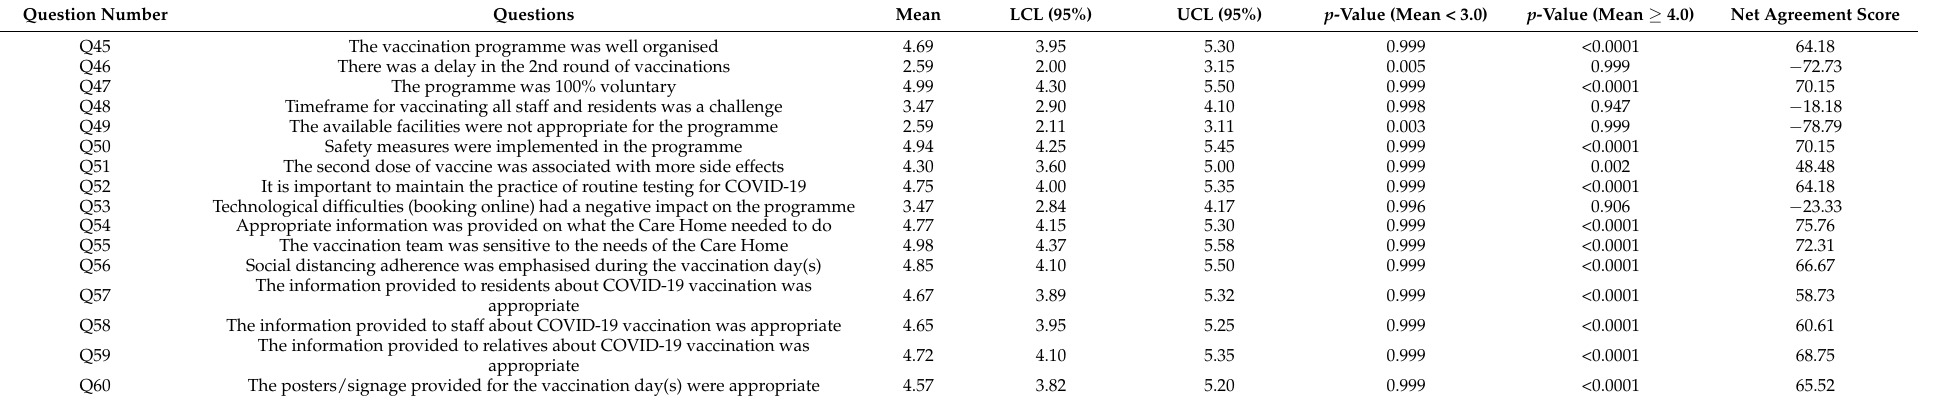
Table 6. Analyses of the implementation of the COVID-19 vaccination program in care